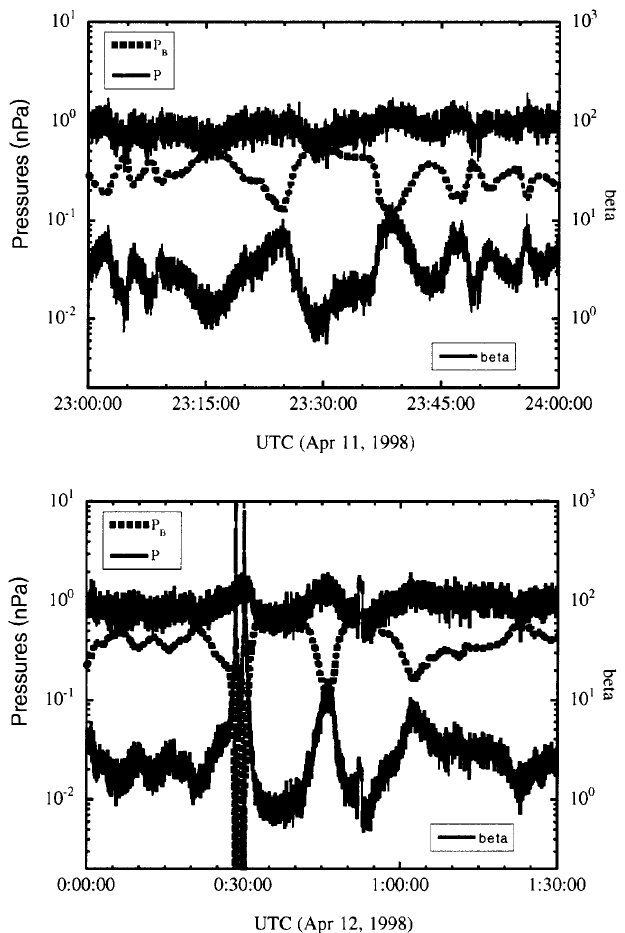
Fig. 4. Same as Fig. 2, but without total pressure, for 3 April and 9 April 1998